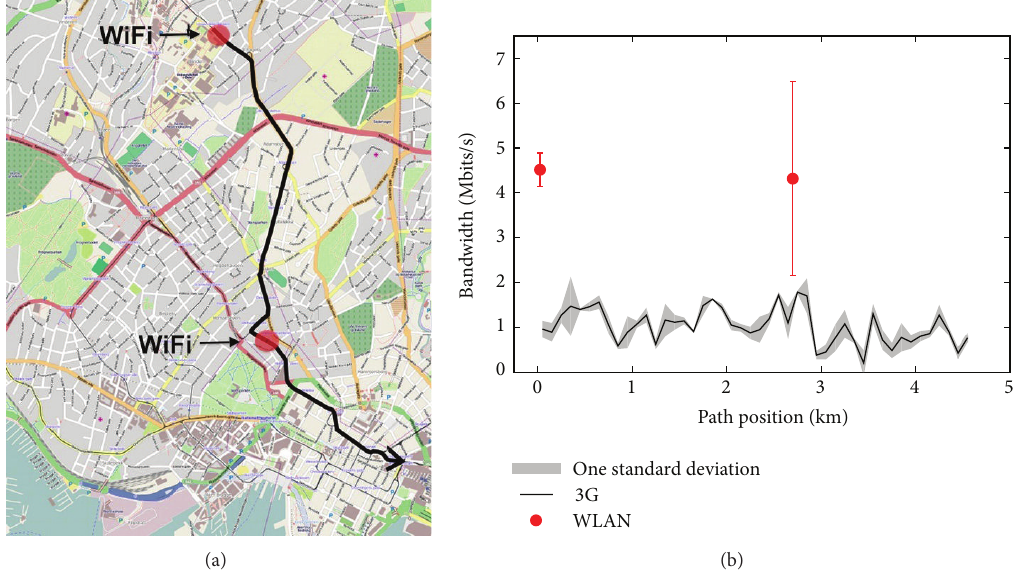
Figure 18: Observed 3G and WiFi download rates while traveling by tram in Oslo. WiFi was only available at the marked